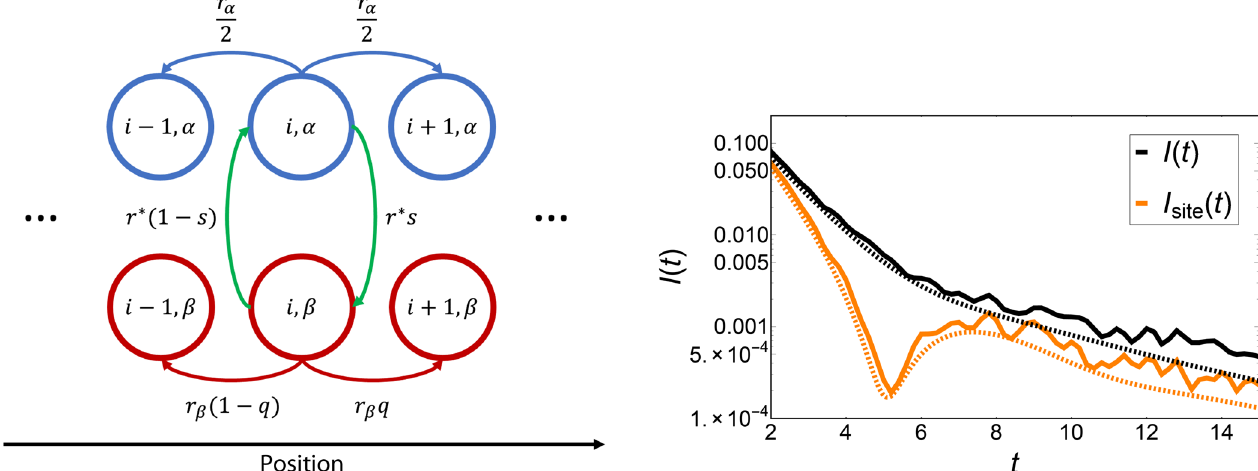
FIG. 5. A sketch of the Markov-jump model in Eq. (106) (left diagram) and the corresponding behavior of the Fisher information (right diagram) for r (cid:3) ¼ 0 . 1 . The solid lines are the results of Monte Carlo simulations ( 2 × 10 5 samples), and the dashed lines are the solution of the master equation (106). In both cases, we consider a model with N ¼ 3 states, extended to N (cid:3) ¼ 6 states by observing the number of rotations modulo 2. As discussed in Sec. III and Appendix D, the Fisher information of the detailed probabilities P α taking into account both the sites and the internal state, is a monotonically decreasing function of time (black lines). By contrast, projecting the dynamics onto only the sites yields a nonmonotonic behavior of the corresponding Fisher information (orange